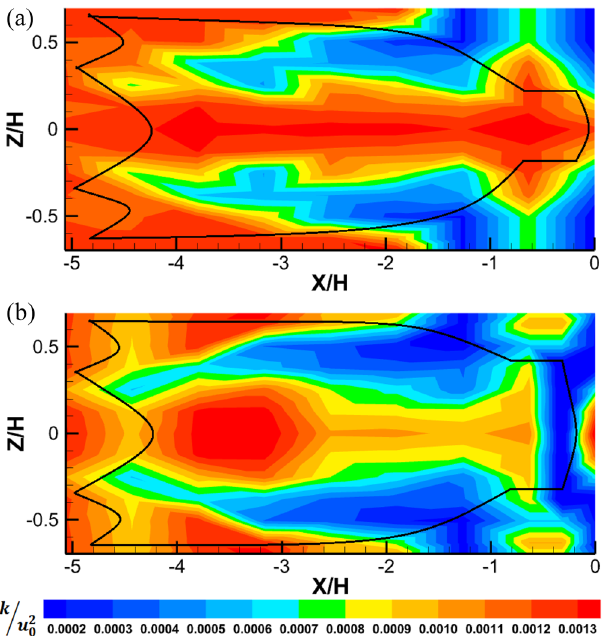
2 Figure 11. Turbulent kinetic energy ( k / u 0 ) develops inside and around midwater trawl net ( a ) Trawl without catch and ( b ) Trawl with catch represented as left to right: front view and bottom